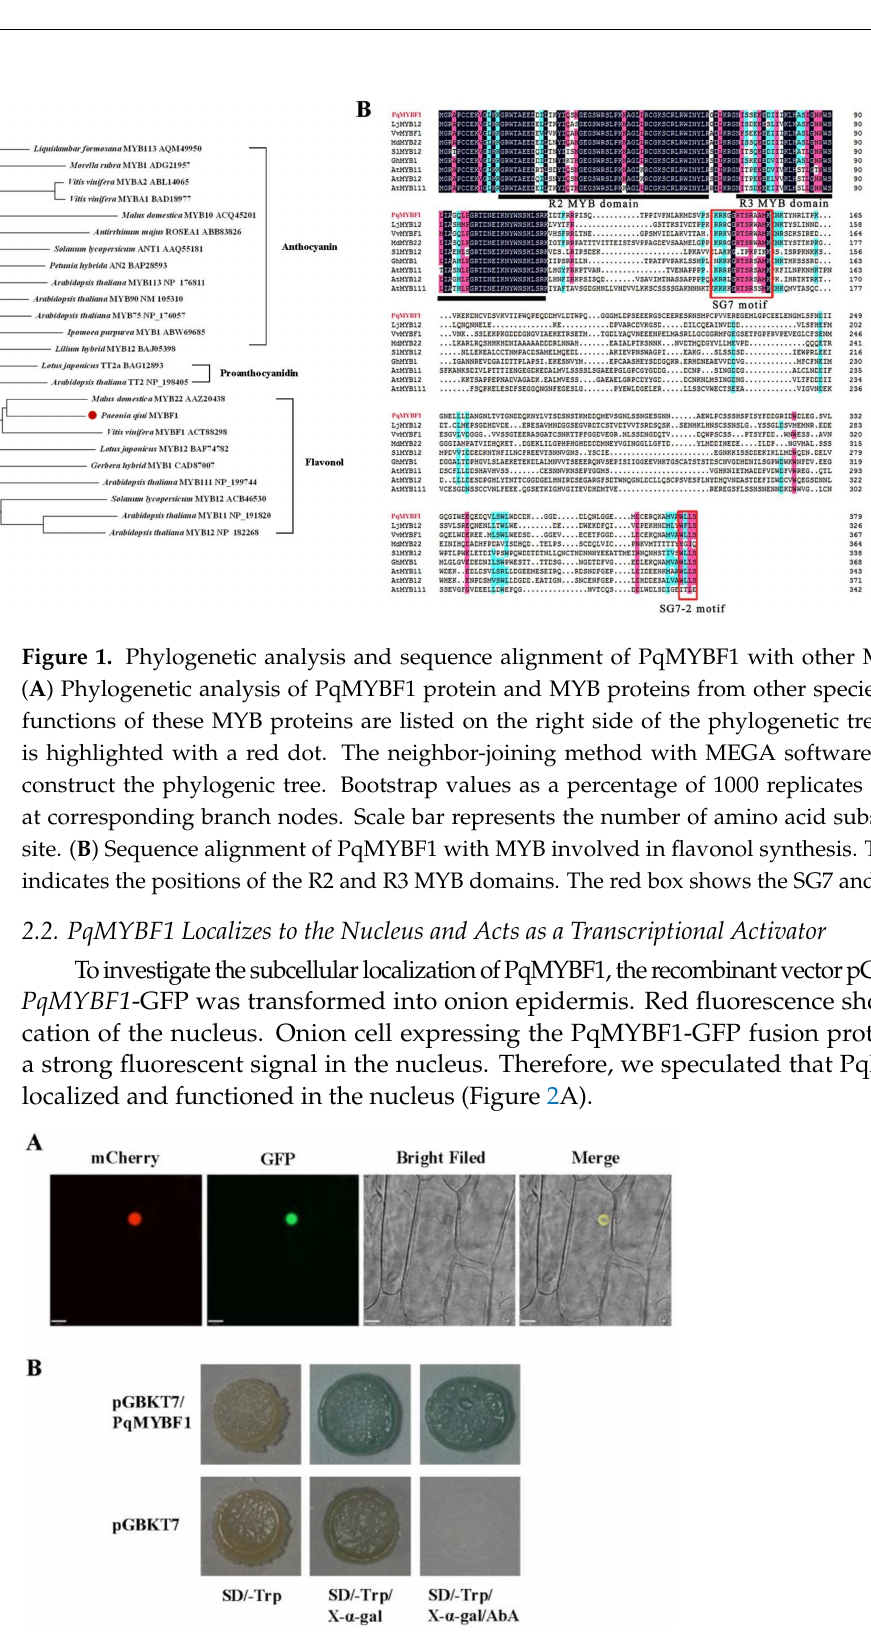
Figure 2. Subcellular localization and transcriptional activity of PqMYBF1. ( A ) Subcellular location of GFP fusion of PqMYBF1. The mCherry protein indicates nucleus localization. Bars = 33 µ m. ( B ) Transcriptional activity of PqMYBF1 in yeast. Y2H transformed with pGBKT7- PqMYBF1 or pGBKT7 vector was grown on SD/-Trp, SD/-Trp with 40 µ g/mL X- α -gal and SD/-Trp with 40 µ g/mL X- α -gal adding 200 ng/mL aureobasidin A (AbA) for three